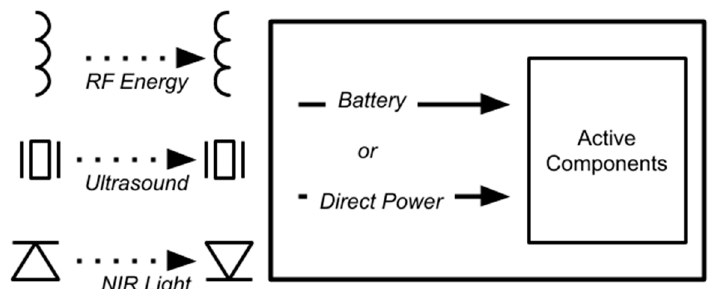
Figure 3. Methods of remote power for implantable devices. RF energy (top-left) can be transmitted through inductors; ultrasound energy (middle-left) can be transmitted through piezoelectric materials; near-infrared (NIR) light (bottom-left) can be transmitted via light-emitting diodes (LEDs) and photoreceptors. The received energy may be either stored in a battery or used directly.